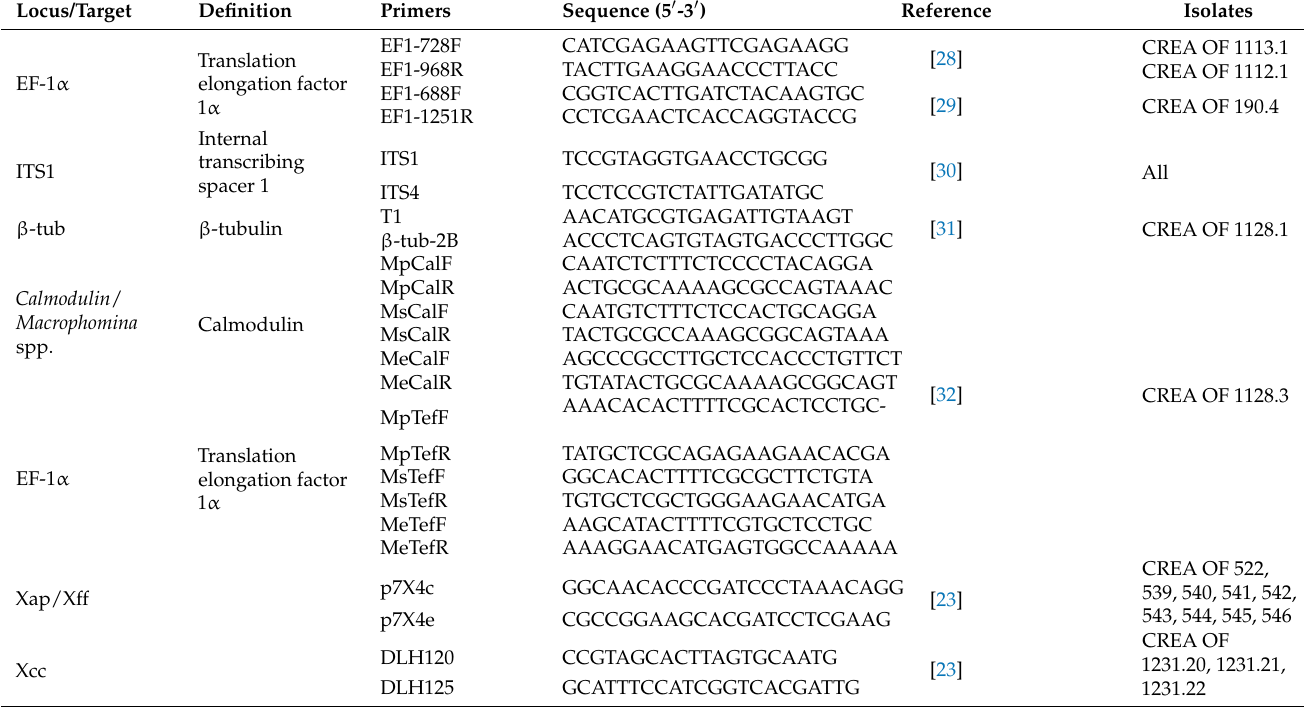
Table 3. Primer pairs used to characterize the